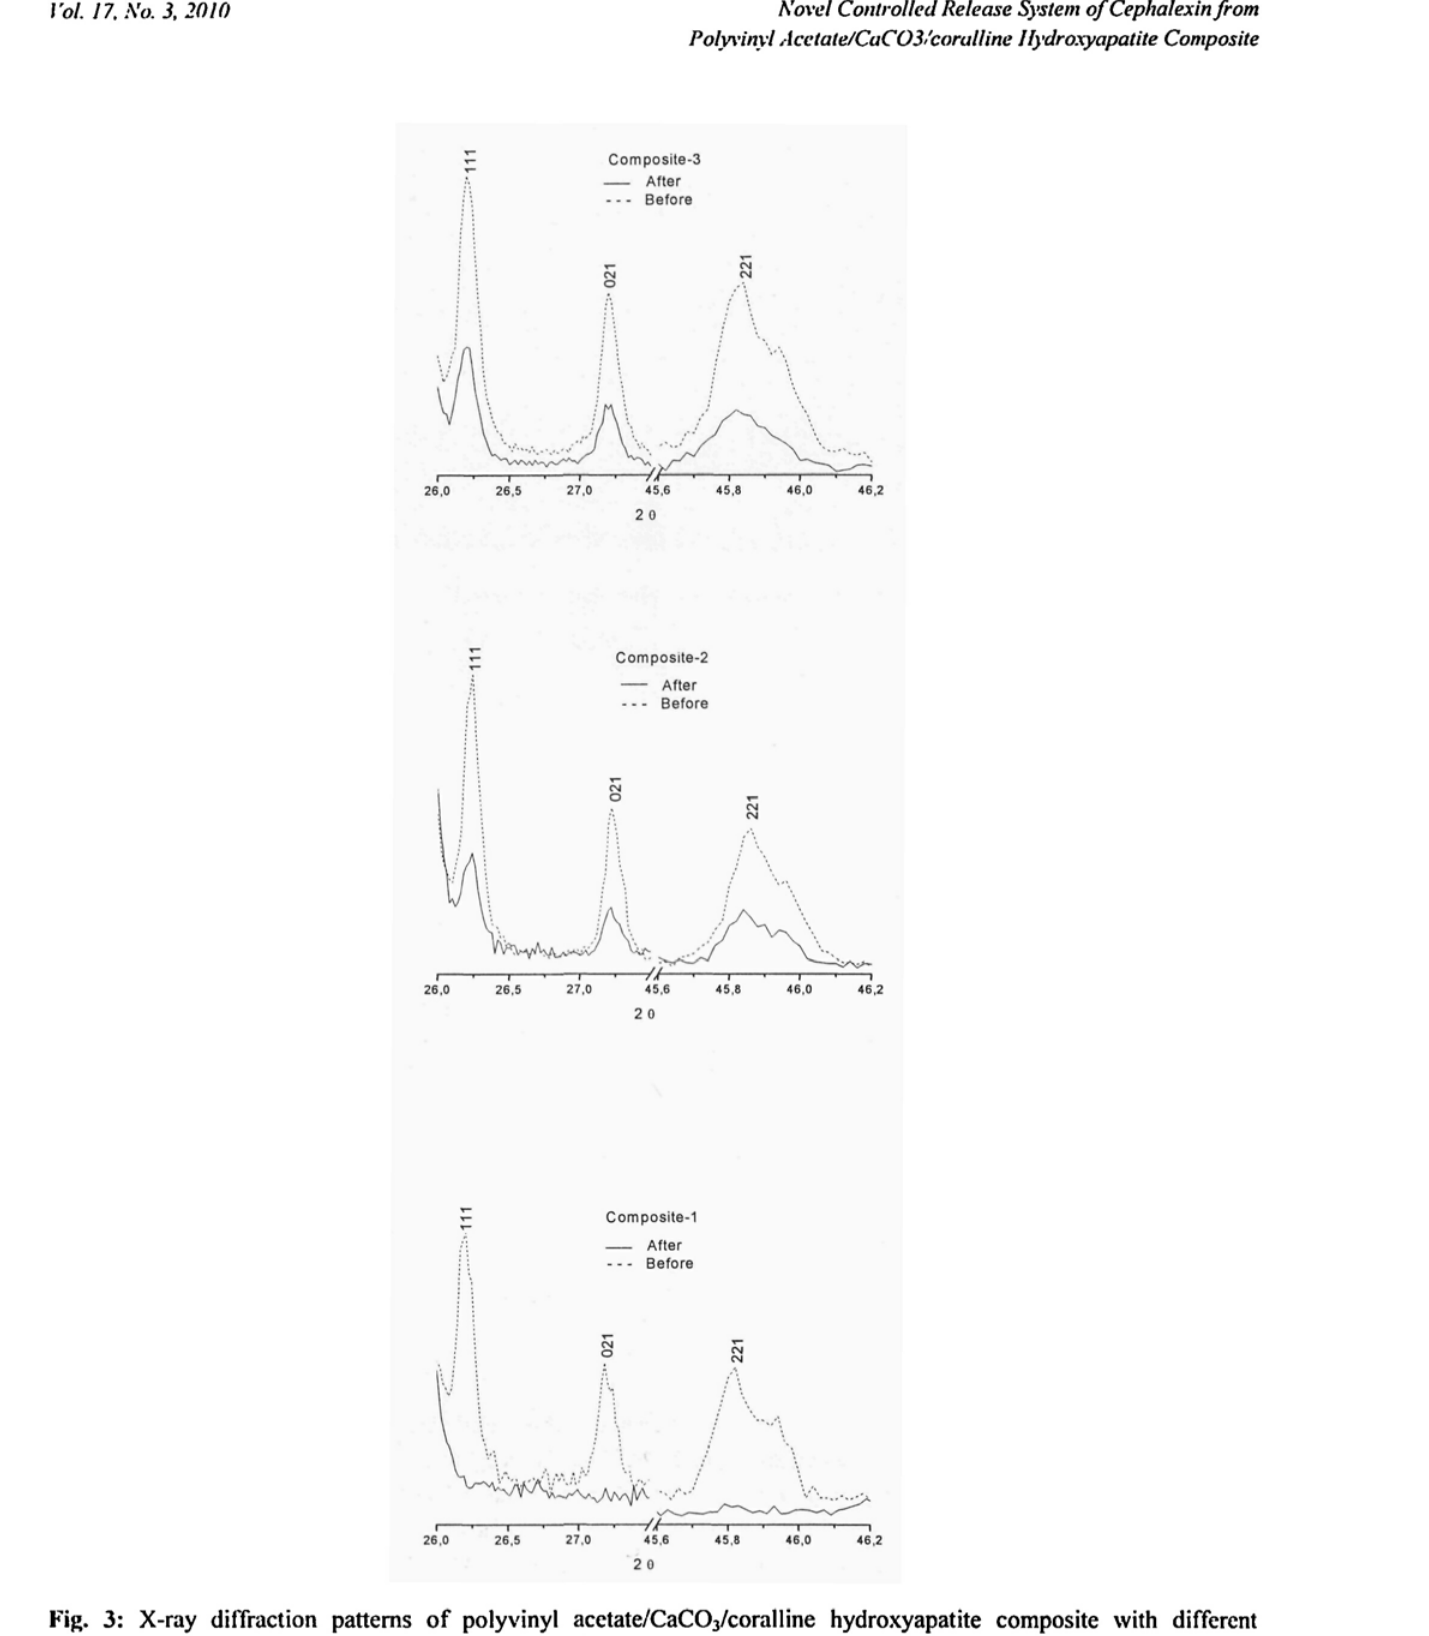
Fig. 3: X-ray diffraction patterns of polyvinyl acetate/CaCO CaCO /I IAP-200 ratio before and after soaking in phosphate buffer saline for 30 days 3